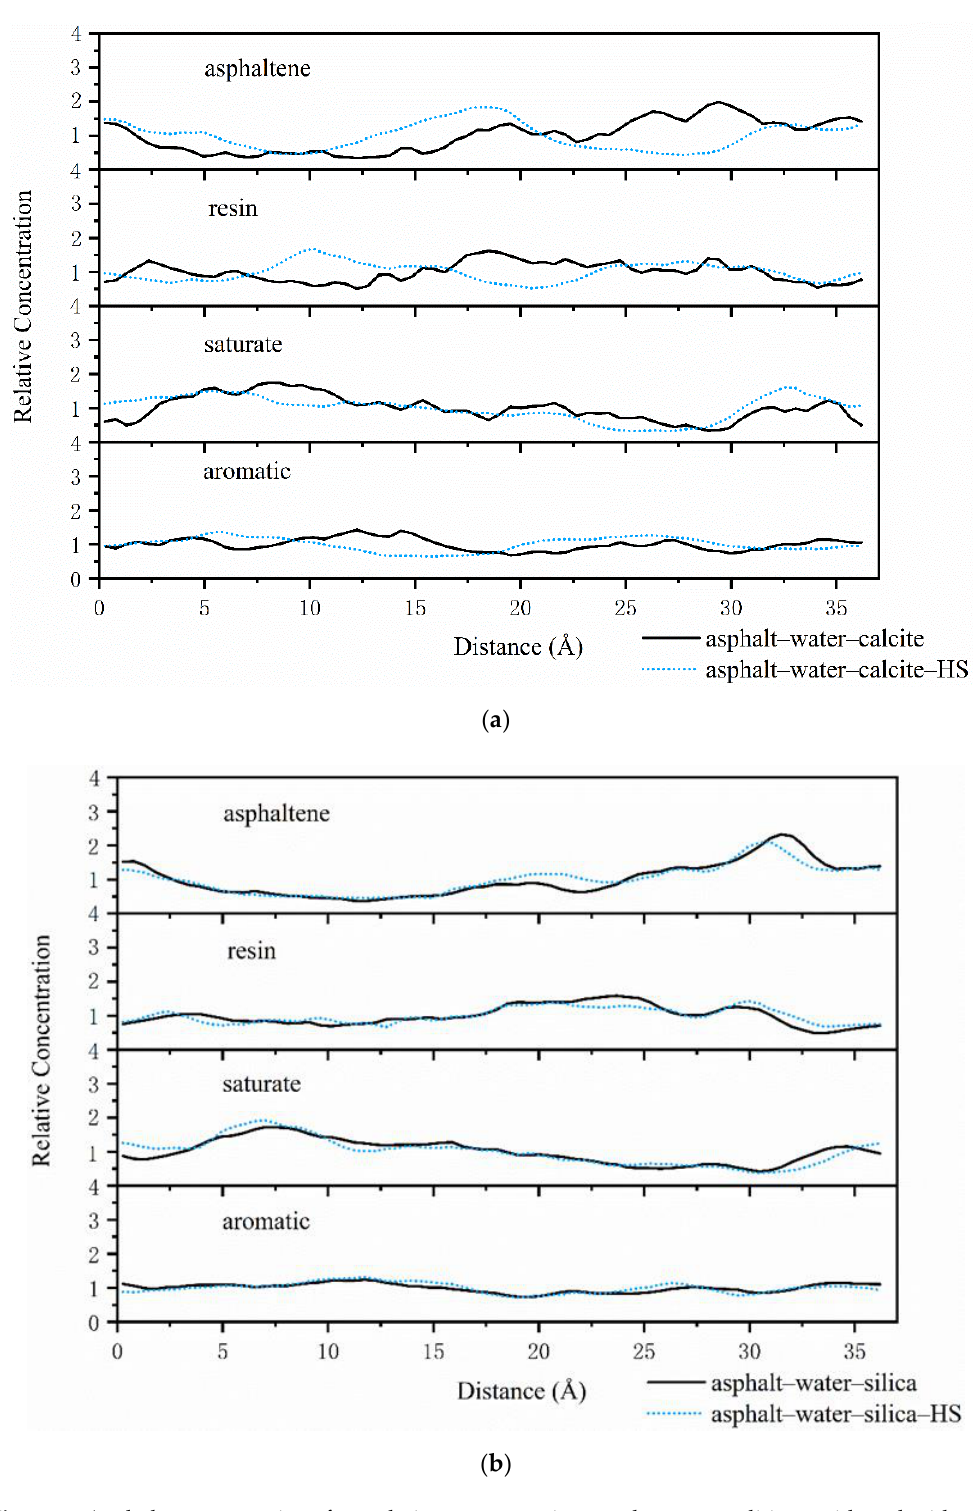
Figure 9. Asphalt–aggregate interface relative concentrations under wet conditions with and without adsorbed water on the aggregate surface: ( a ) asphalt–water–calcite and ( b ) asphalt–water–silica. The water adsorbed on the surface of calcite had a distinct impact on the asphalt–calcite interface system, as can be seen in Figure 8a. Adsorbed water significantly decreased the peak concentration of the resin, extended the appearance distance of the resin and asphaltene, and declined the aggregation concentrations of substances with high polarity (asphaltene and resin) on the surface of the calcite. Due to lower mass fractions of saturate components, the diffusion rate of the saturate was